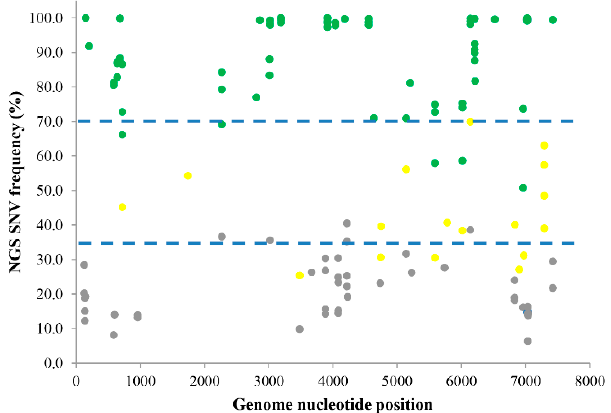
Figure 1. Comparison of SNV calling between NGS and pyrosequencing. Each dot represents an individual SNV identified by NGS in extracts from either F4-c1 culture (62 to 240 dpi) against the reference sequences M16632, or the HAV HM175 positive clinical sample against the reference sequence M14707. Phred quality score >30 for each SNV ( p < 0.001 for the error rate). SNVs were validated by pyrosequencing as a single-SNV (green), mixed-SNVs (yellow), or a non-SNV (grey). The dotted blue lines were artificially drawn to delineate different groups containing the majority of single-, mixed-, and non-SNVs, respectively. The X -axis represents the nucleotide position along the respective reference genomes. The Y -axis represents the frequency of each SNV from NGS results.